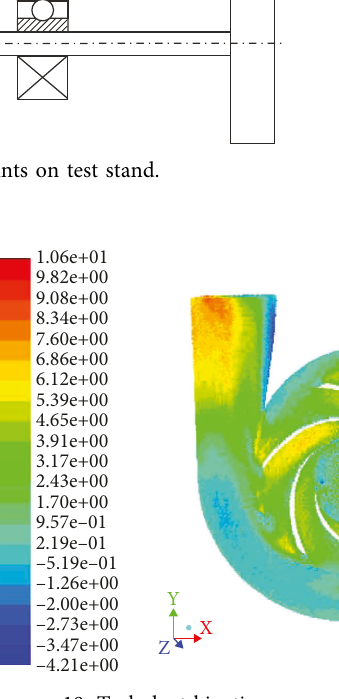
Figure 17: Nephogram of pressure distribution of plastic cen- trifugal pump.